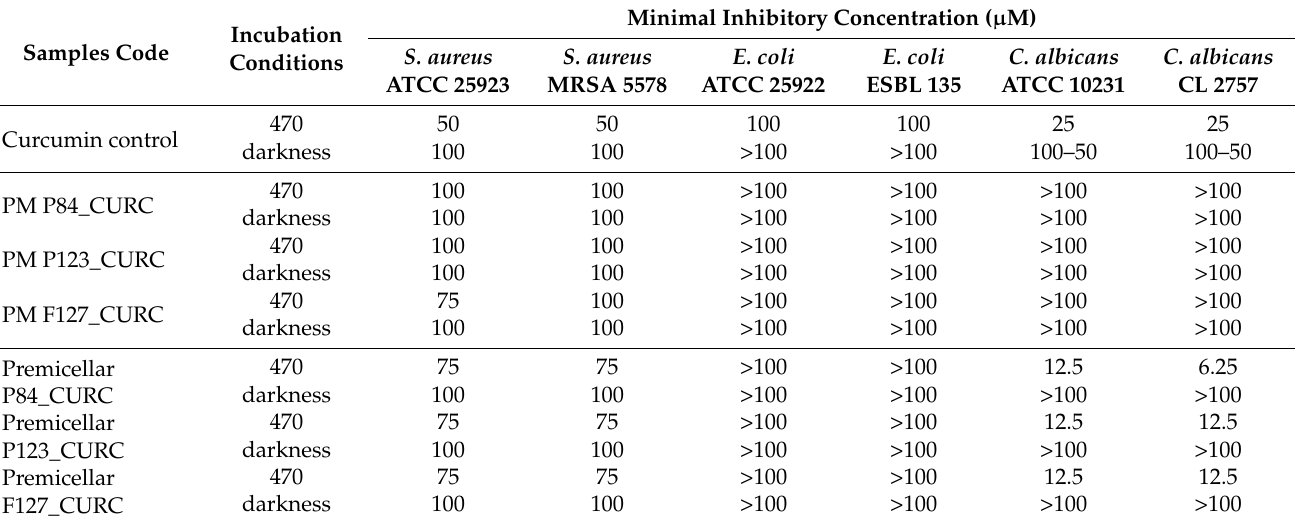
Table 6. Minimal inhibitory concentration of tested Pluronic and Curcumin